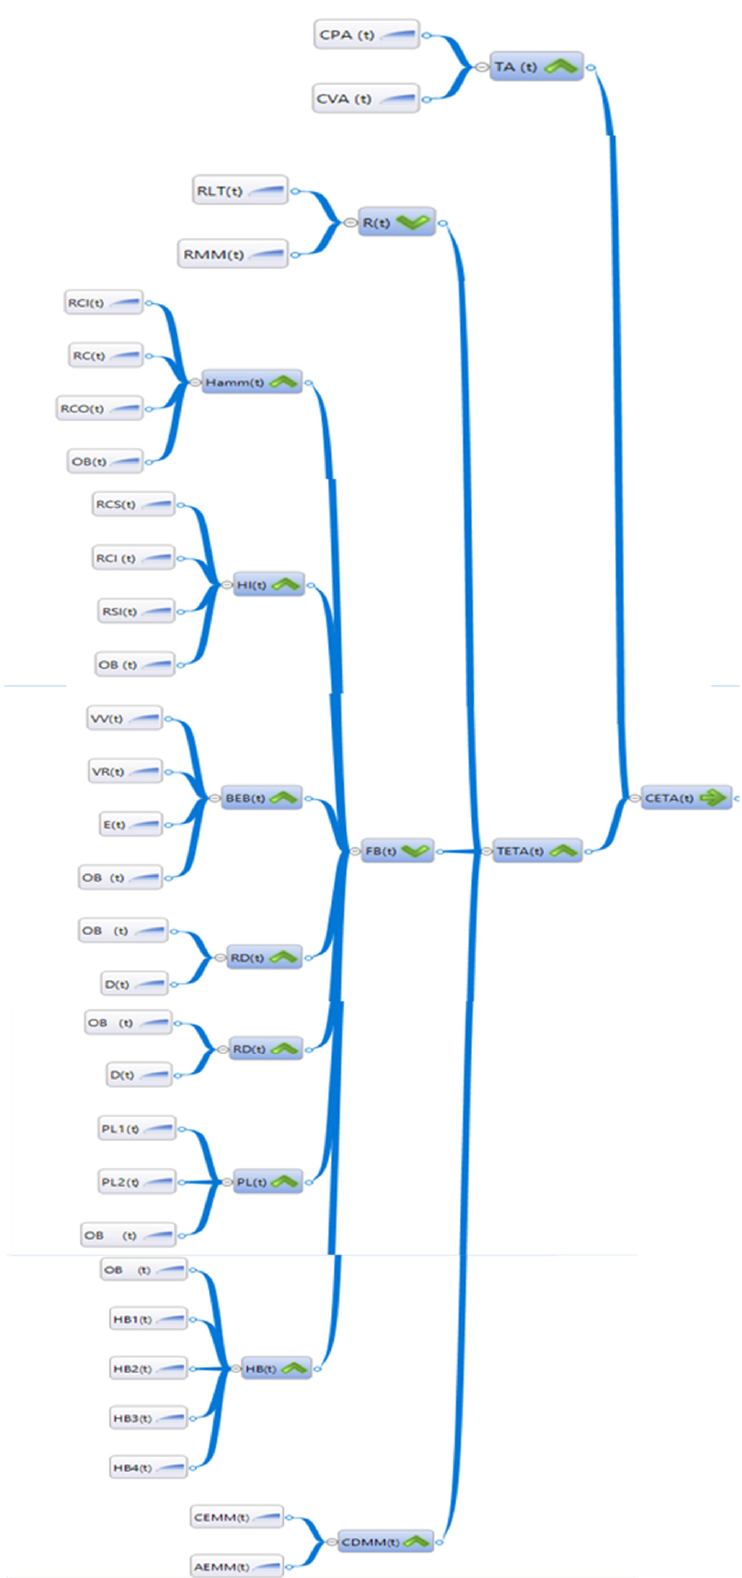
Figure A2. Logical tree representing the truth degree of the composed predicate “there is a bullish scenario at time t ”, CETA ( t ) .